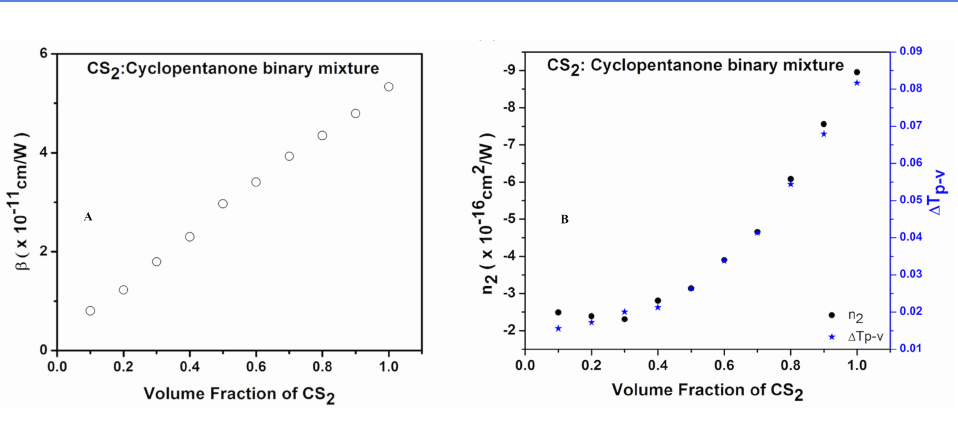
Figure 5 Variations of n 2 and (cid:49) T p - v in CAZS with varying volume fractions of carbon disulfide in bi- nary liquid mixtures of carbon disulfide with acetone for without-flow condition. DOI: 10.7717/peerjpchem.23/fig-5